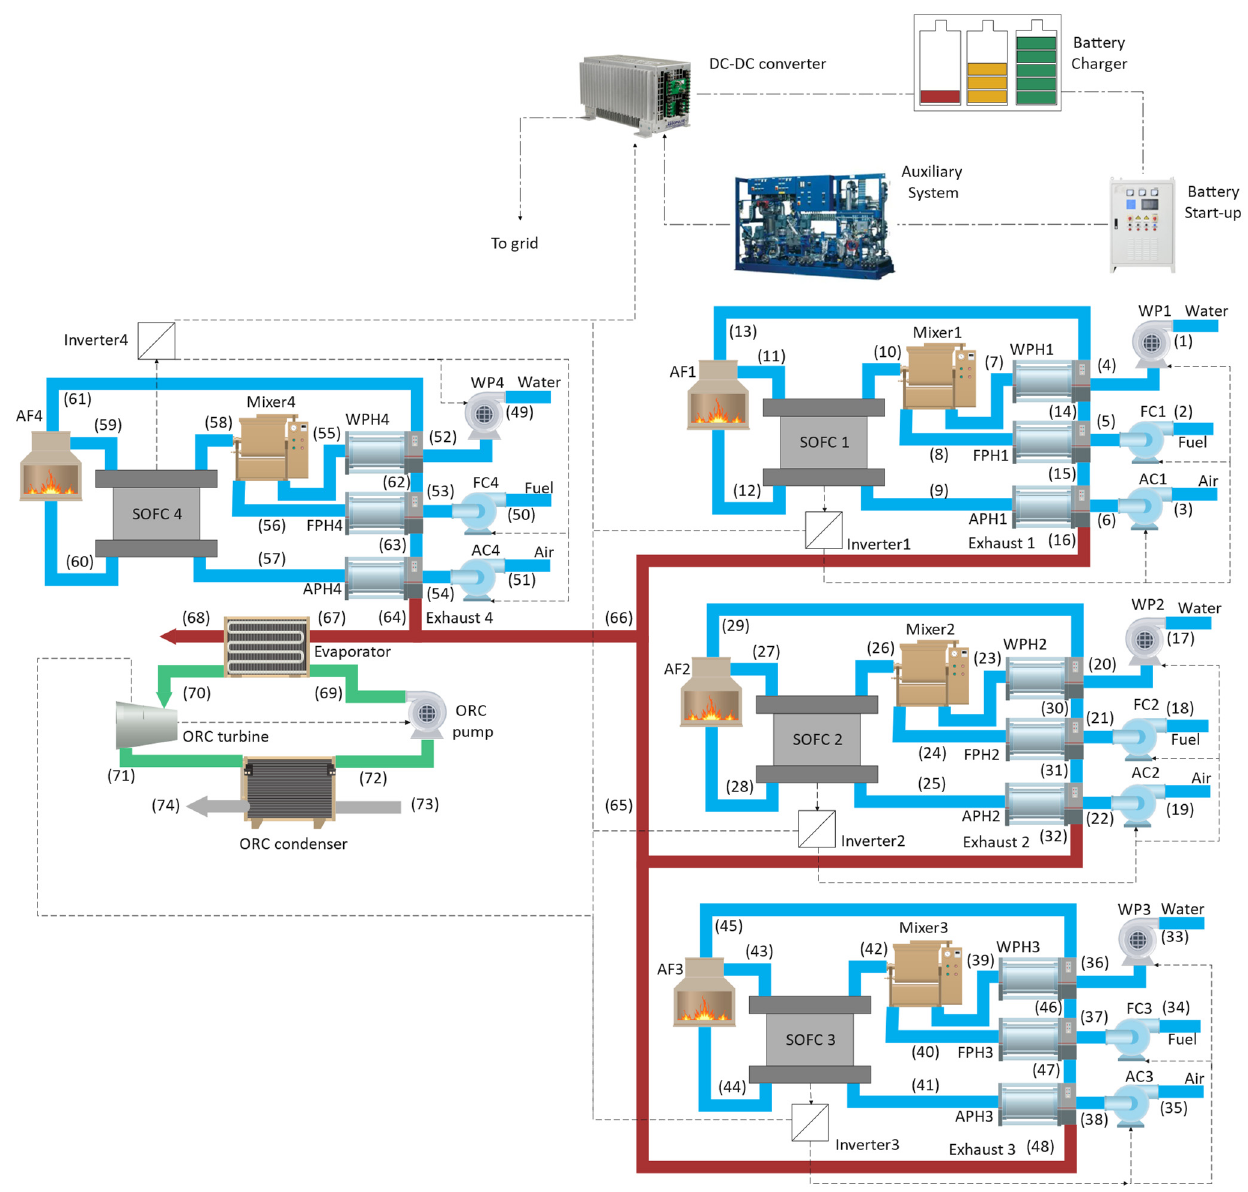
Figure 1. The suggested system design that uses ORC and SOFC units to generate the required elec- tricity for the charging station benefiting from the batteries as the